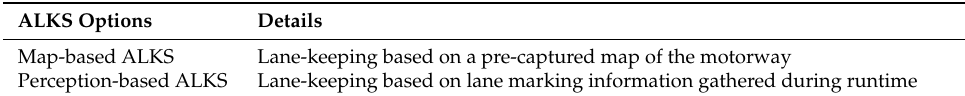
Table 1. Implemented options of the utilised ALKS-based ADS.